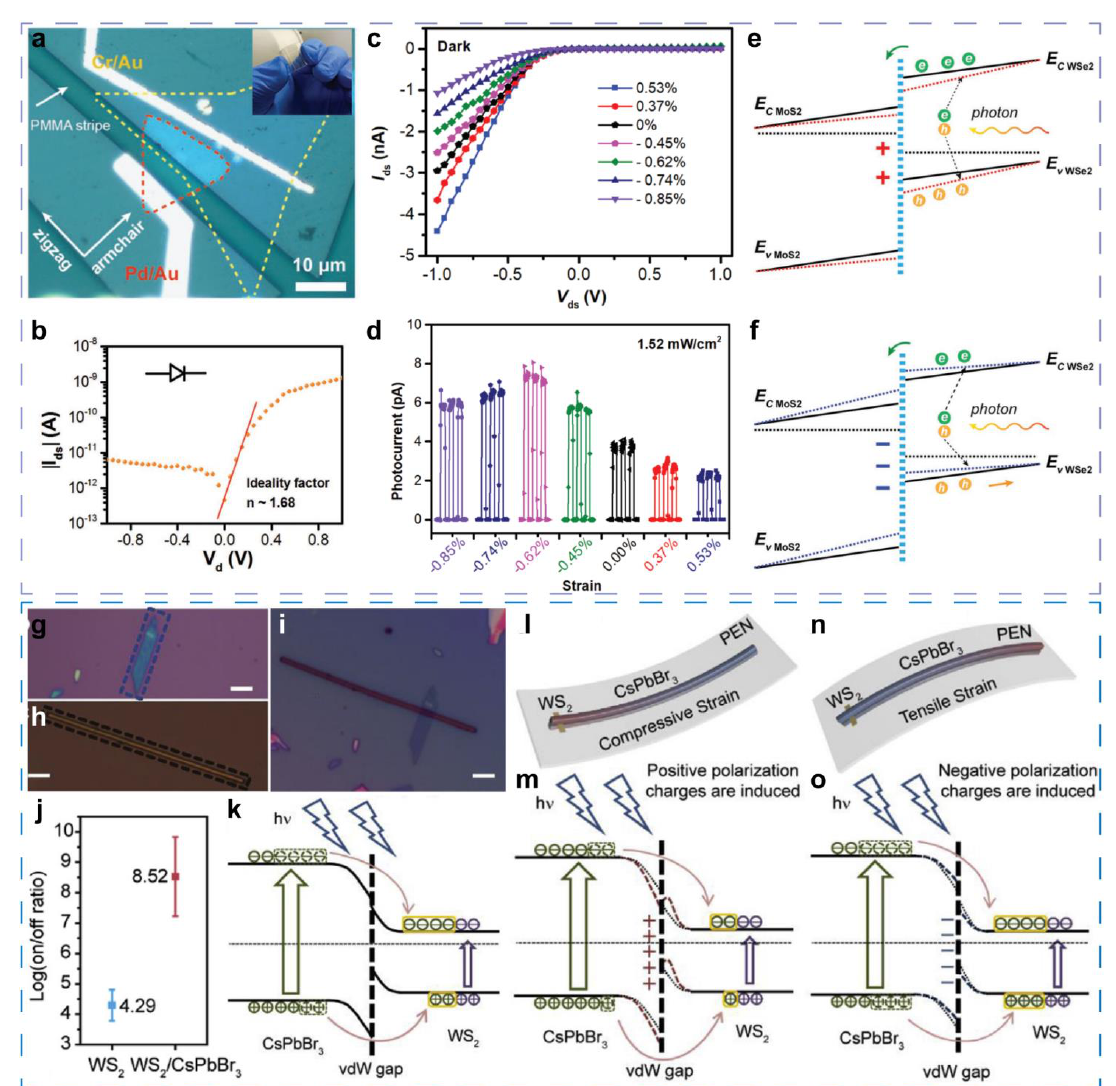
Figure 6. Multifunctional sensors based on 2 − D materials. ( a ) Optical image of the MoS 2 /WSe 2 vdWH photodiode. ( b ) I − V curve of the MoS 2 /WSe 2 vdWH diode. ( c ) I − V curve of the MoS 2 /WSe 2 vdWH photodiode in dark with different strains. ( d ) Strain − dependent photocurrent of the MoS 2 /WSe 2 vdWH photodiode under the illumination at applied bias of 0 V. ( e , f ) Schematic illustration of the heterojunction energy band with positive and negative piezopolarization induced by strain, respectively. Reproduced with permission. [67] Copyright 2018, Wiley-VCH. ( g , h ) Optical image of the chosen WS 2 flake and CsPbBr 3 nanowire for constructing a vdWH, respectively. ( i ) Optical image of the as − assembled WS 2 /CsPbBr 3 vdWH. ( j ) Statistics the maximum on/off ratio. ( k ) Schematic diagram of the transfer of light-induced carrier from CsPbBr 3 to WS 2 . ( l , m ) Schematic diagram of the vdWH and energy band under compressive strain, respectively. ( n , o ) Schematic diagram of the vdWH and energy band under tensile strain, respectively. Reproduced with permission. [82] Copyright 2019, Elsevier.